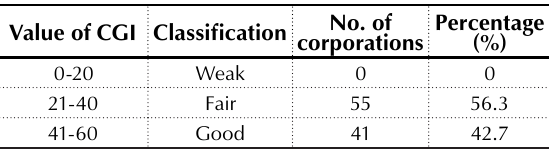
Table 2. Classification of corporations based to